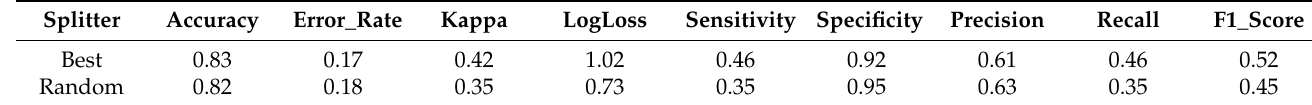
Table 5. Metrics for splitter parameter.